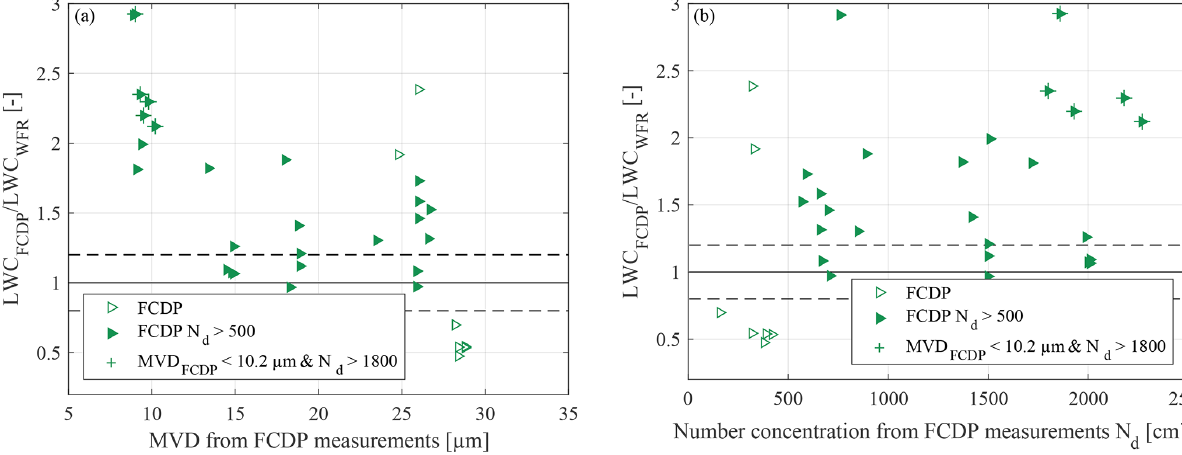
Figure 15. Effect of MVD on LWC measurements from the FCDP (a) and effect of number concentration (b)